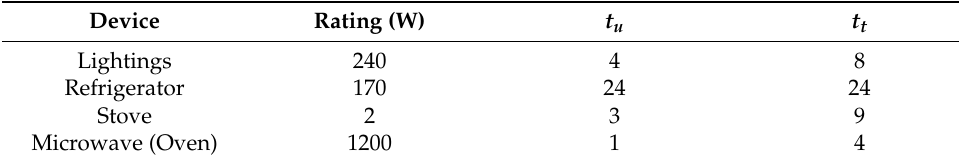
Table 2. Load Description.